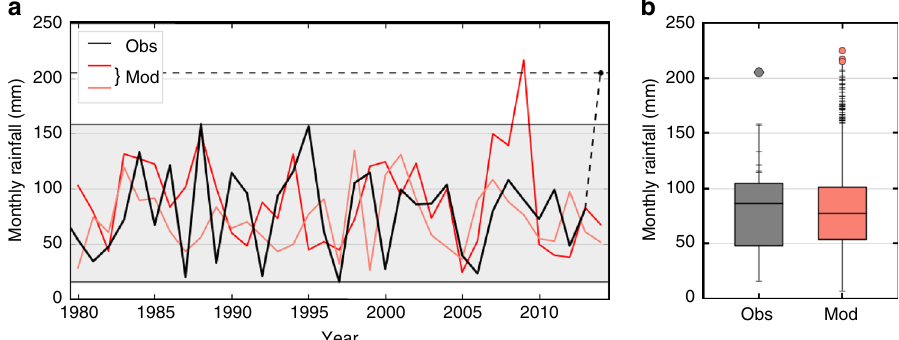
Fig. 1 Unprecedented monthly rainfall. a South east England January monthly rainfall totals from 1979 to 2014, in mm ( black ) and two examples from model simulations ( red ). The black dashed line indicates the unprecedented January 2014 observed rainfall total. b Distribution of south east England January monthly rainfall totals from observations ( grey ) and the model ( red ). The box represents the interquartile range and the range of the whiskers represents the minimum and maximum monthly rainfall totals. The grey dot indicates the record observed monthly rainfall of January 2014 and ticks on the upper end of observations show the values in the upper quartile of previous events. Ticks on the model line indicate months above the observed record prior to 2014,